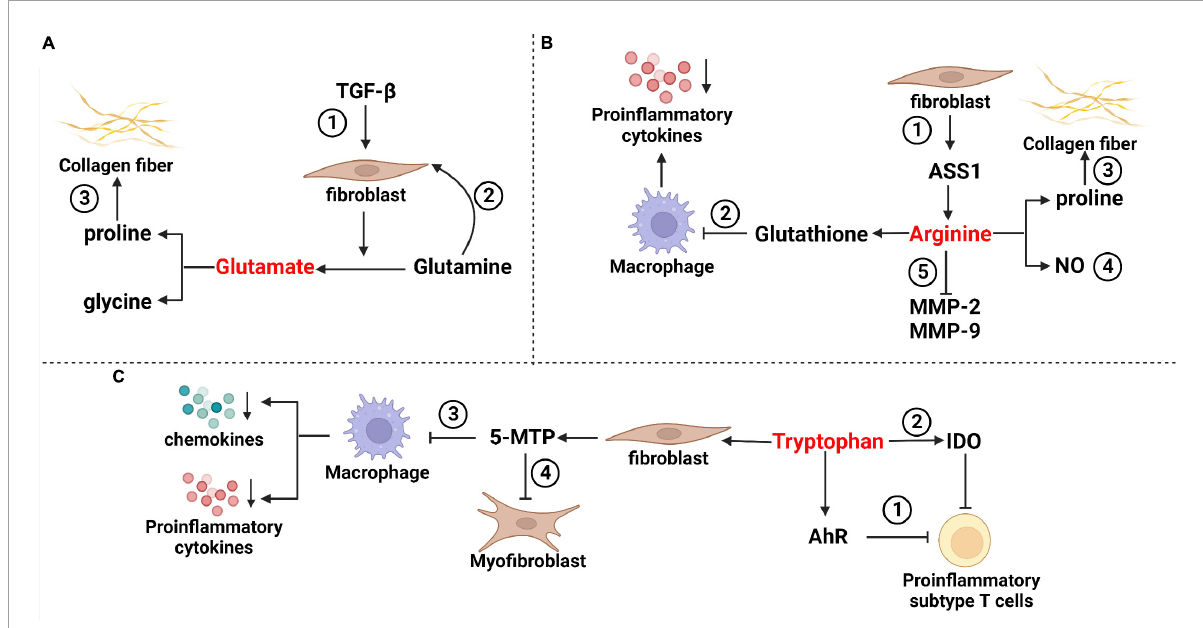
FIGURE1 Mechanisms of partial amino acids in pulmonary fibrosis. (A) Glutamate in pulmonary fibrosis (cid:192) TGF- β stimulated fibroblasts, and increased the decomposition of glutamine and glutamate levels. (cid:193) Glutamine promoted anti-apoptosis of fibroblasts through epigenetic regulation of XIAP and survivin. (cid:194) Glutamate metabolite proline is a rate-limiting substrate for collagen formation in pulmonary fibrosis. (B) Arginine in pulmonary fibrosis (cid:192) Arginine has a variety of sources, including fibroblasts that can synthesize arginine via the ASS1 pathway often used in research experiments. (cid:193) Arginine can induce an increase in glutathione and inhibit the release of proinflammatory cytokines such as TNF- α , IL-1 β and IL-6 from macrophages. (cid:194) Arginine metabolite proline is a rate-limiting substrate for collagen formation in pulmonary fibrosis. (cid:195) The NO isoforms of arginine metabolites include iNOS and cNOS, which have bidirectional effects on airway inflammation. (cid:196) Arginine inhibits the activation of NF- κ B light chain enhancer and reduces the activities of matrix metalloproteinase-2 (MMP-2) and MMP-9 in fibrosis. (C) Tryptophan in pulmonary fibrosis (cid:192) Tryptophan acts with aryl hydrocarbon receptors to inhibit proinflammatory subsets of T cells. (cid:193) Tryptophan metabolites produced by IDO can indirectly reduce T-cell inflammation. (cid:194) Tryptophan is metabolized to 5-MTP in fibroblasts, which can inhibit macrophage activation and block the release of proinflammatory cytokines and chemokines. (cid:195) 5-MTP inhibits myofibroblast formation by interfering with the TGF- β /SMAD3 and PI3K/Akt